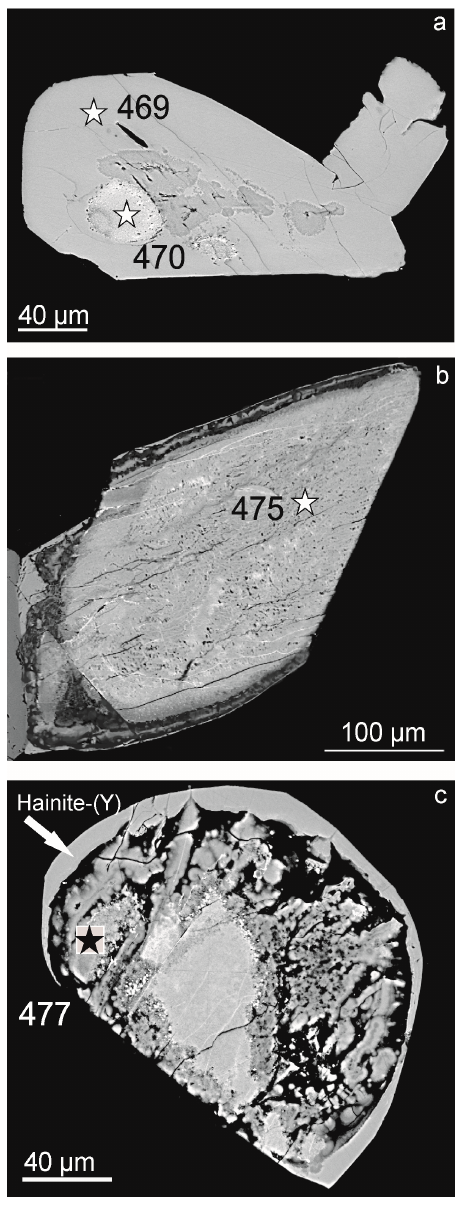
Figure 1. Morphology of titanosilicates from the nepheline syenite pegmatite, Sakharjok massif, Kola Peninsula. Backscattered electron images. Asterisks indicate point of microprobe analyses; analyses numbers correspond to Table 2. ( а )—“eye-like”titanosilicate (an. 470), hainite-(Y) (an. 469), ( b )—“porous” (an. 475), ( c )—“loose” titanosilicate (an. 477).